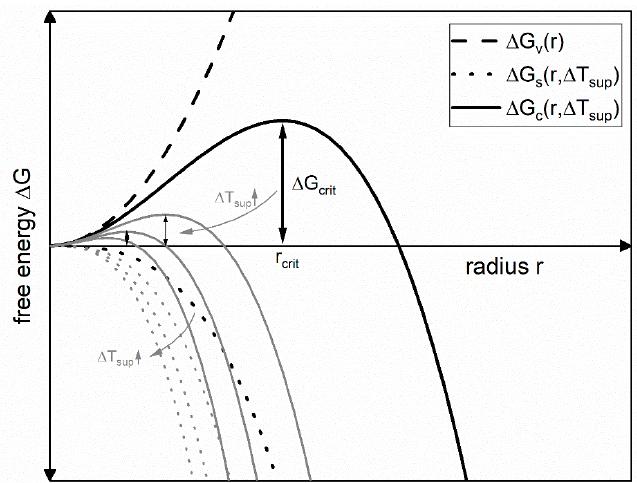
Figure 2. Representation of the critical enthalpy difference Δ G c with maximum Δ G crit and its dependence on the amount of supercooling Δ T sup , as well as on the radius r of the idealized crystallization nuclei [10].